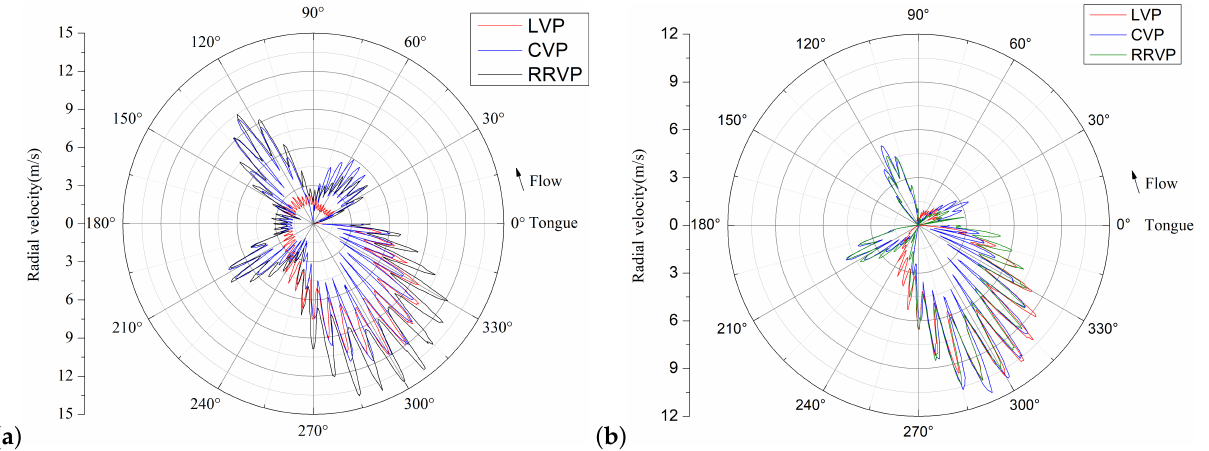
Figure 11. Streamline flow in the corner for different volutes: ( a ) LVP, ( b ) CVP, ( c ) RRVP.